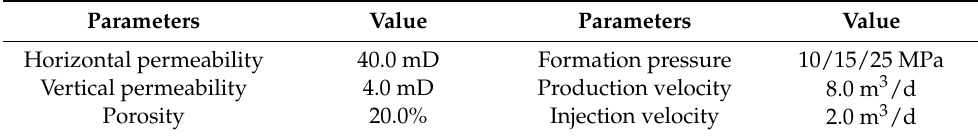
Figure 4. 3D homogeneous reservoir model containing five-spot well pattern. Table 2. Numerical model